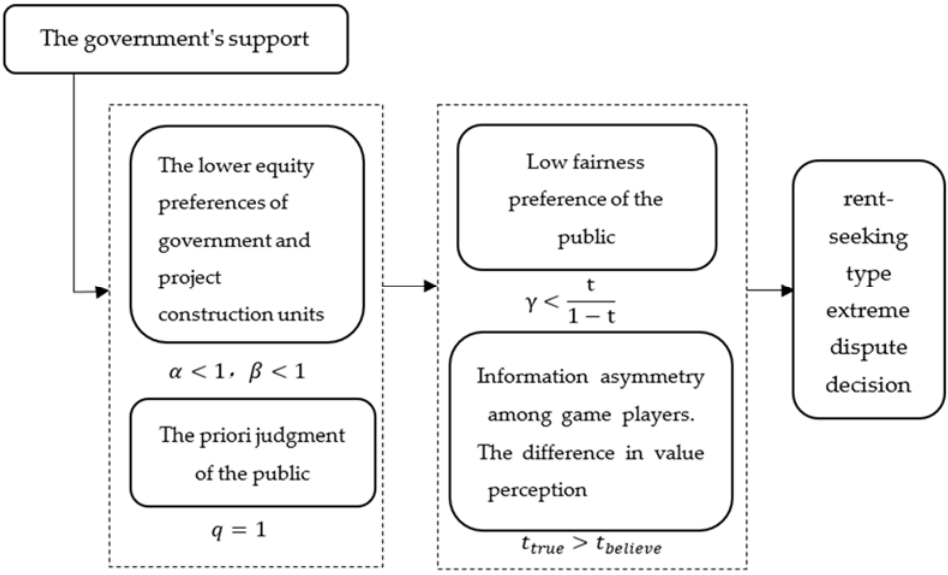
Figure 4. The formation path diagram of rent-seeking type extreme dispute decision.